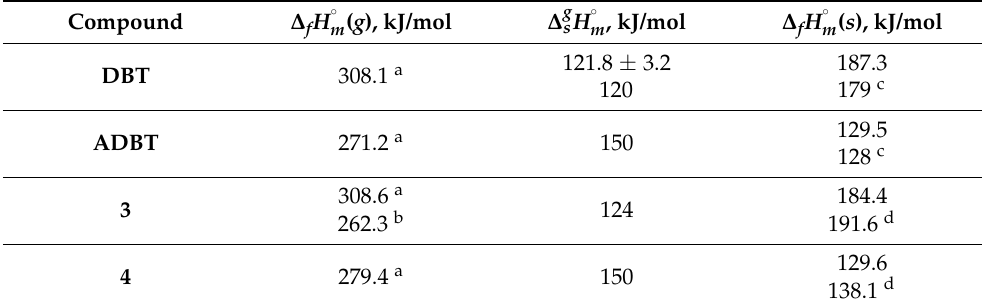
Table 4. The enthalpies of formation in the gas phase ( ∆ f H ◦ m ( g ) ) and solid state ( ∆ f H ◦ m ( s ) ) along with the sublimation enthalpies ( ∆ g s H ◦ m ) for dinitrobenzotriazoles ( DBT and ADBT ) and relative dinitrotriazolopyridines ( 3 and 4